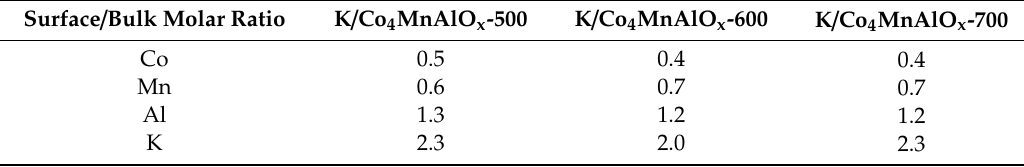
Table 4. Relation of surface to bulk concentrations of individual components.